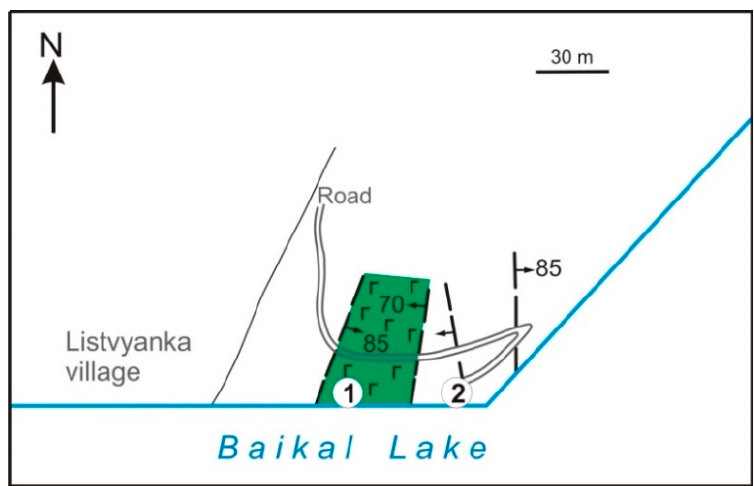
Figure 1. Major tectonic elements of the Irkutsk Promontory of the southern part of the Siberian craton (modified after [26–28]).